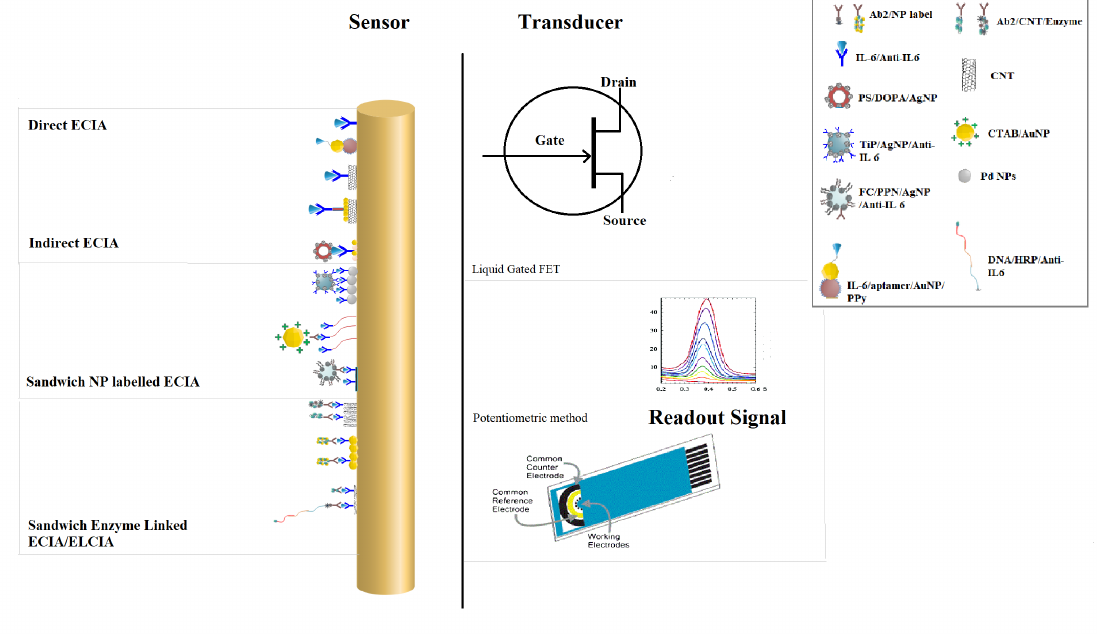
Figure 2. Different sensing mechanisms developed for IL-6 detection. Direct electrochemical immunoassay (ECIA) based on IL-6 and the primary antibody (Ab 1 ) interaction [100]; using a conjugate of polypyrrole-Au Nanoparticles-aptamer [101]; carbon nanotubes (CNTs) coated with (Ab 1 ) [102]; carbon nanotubes coated with gold nanoparticles (AuNPs) and (Ab 1 ) [103]. Indirect electrochemical immunoassay in which a competitive antigen bound to AgNP-coated Polystyrene nanobeads [104]. Sandwiched electrochemical immunoassay in which a secondary antibody (Ab 2 ) is either coated with nanoparticles of Titanium Phosphate (TiP) and silver [105]; gold [106]; ferrocene (FC)-loaded porous polymeric nanoparticle (NP) [107]; or linked with enzymatic label directly or through